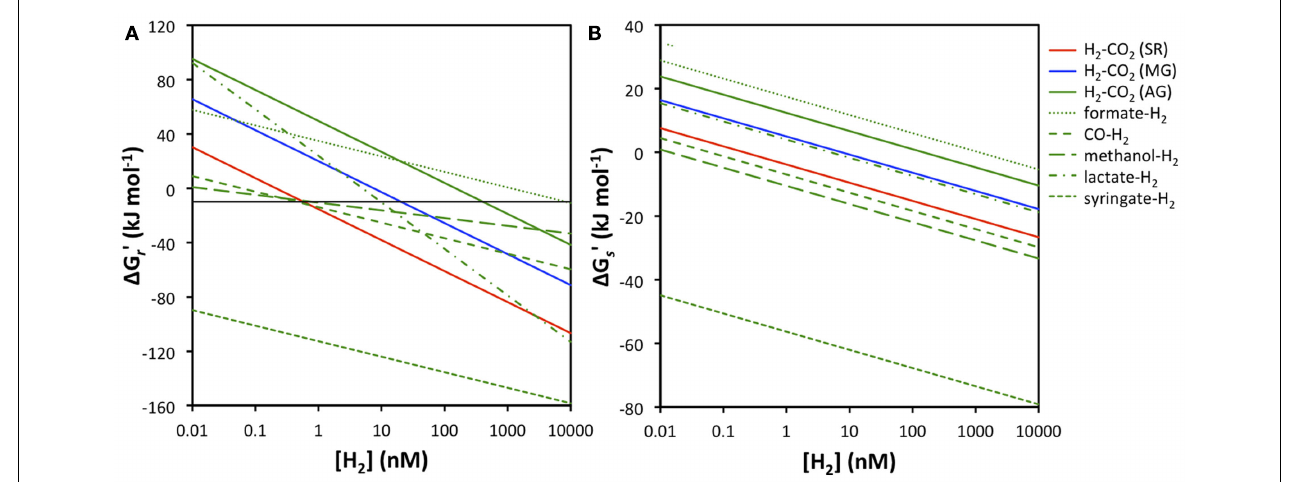
) . All calculations s